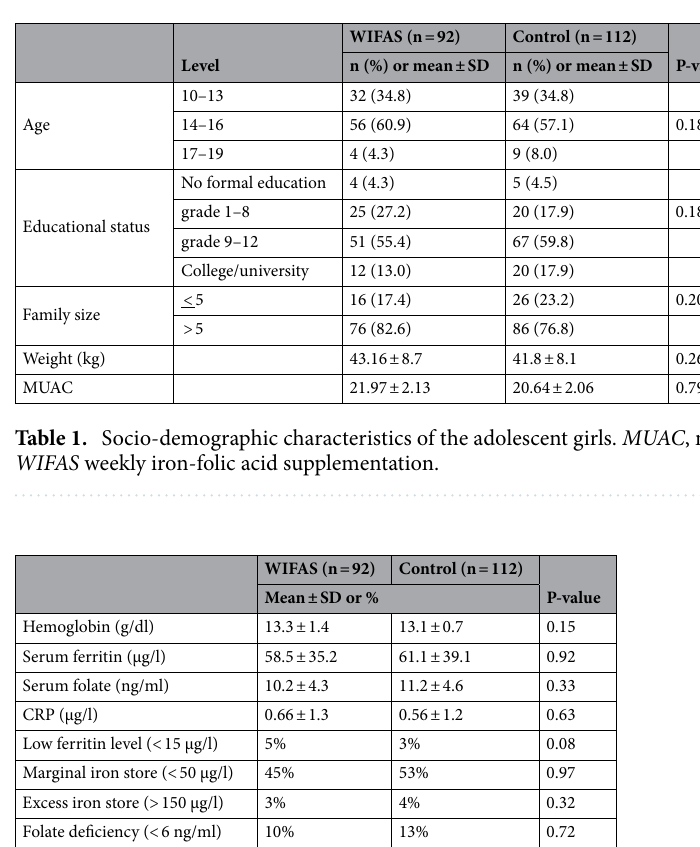
Table 2. Hemoglobin, iron, and folate status of adolescent girls at baseline. CRP C-reactive protein, SD standard division, WIFAS weekly iron-folic acid supplementation; means were compared using t-test. P-values < 0.05 were considered statistically